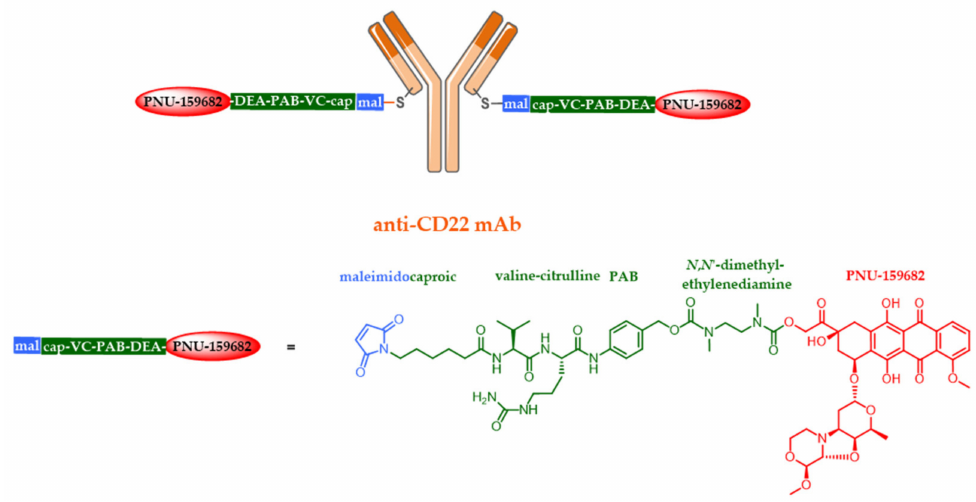
Figure 10. Homogeneous ADC carrying an anthracycline derivative